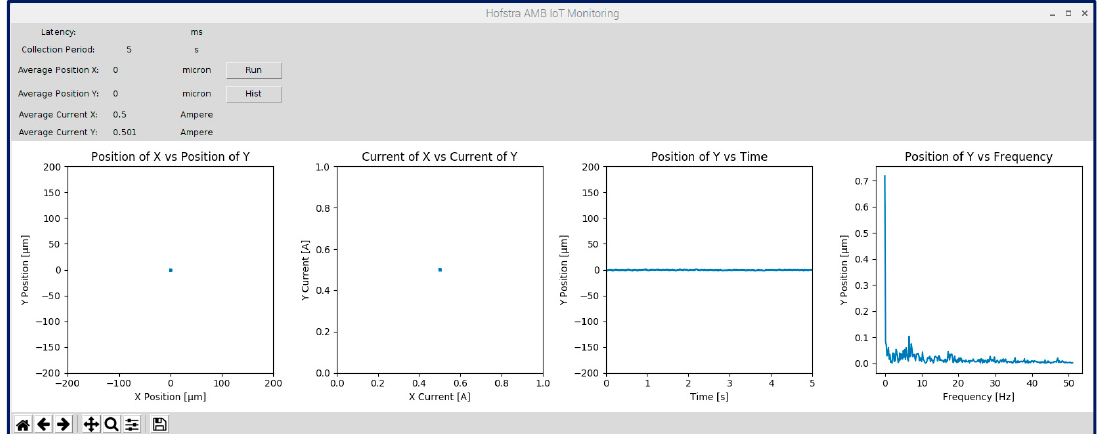
Figure 6. AMB IoT condition monitoring GUI display for non-rotating bare shaft.